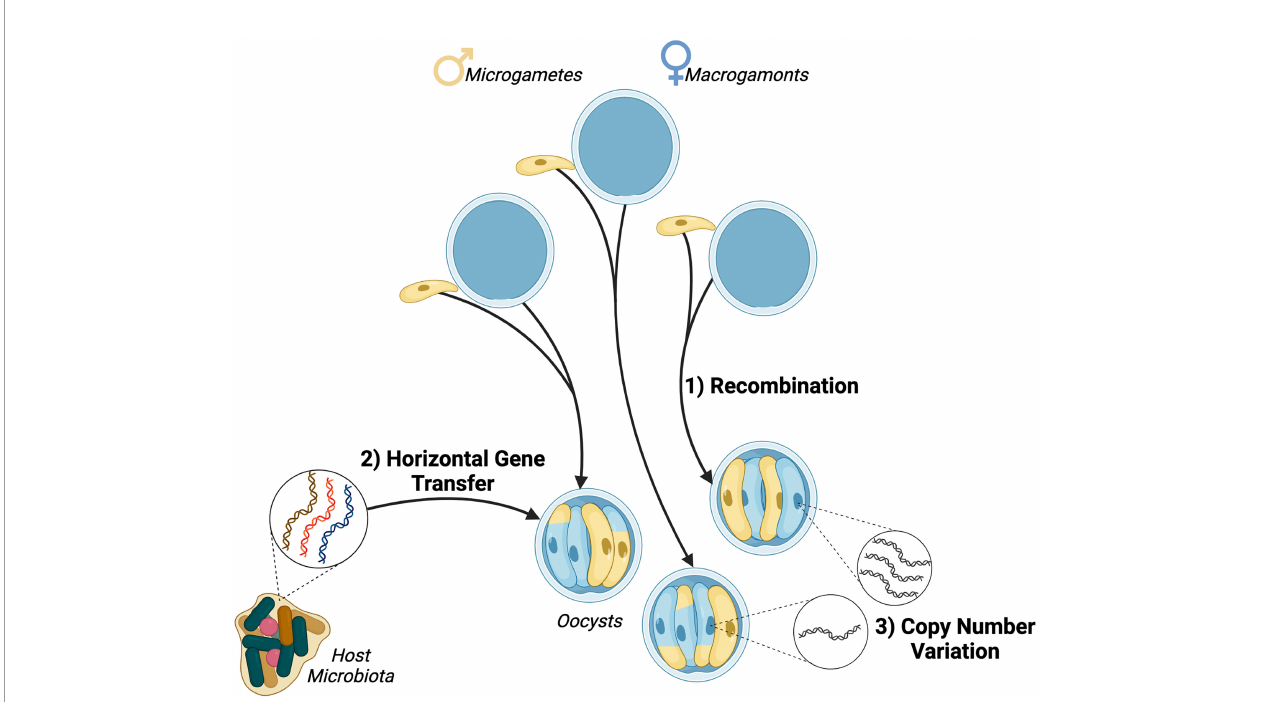
FIGURE 1 | Sources of genetic diversity in Cryptosporidium parasites. 1) Recombination occurs during sexual replication and meiotic divisions distribute parental alleles, resulting in recombinant progeny. 2) Horizontal gene transfer of bacterial genes has been observed in Cryptosporidium species suggesting a link with the host gastrointestinal microbiota. 3) Copy number variation has been observed in at least 13 Cryptosporidium parvum genes with implications for parasite host range and